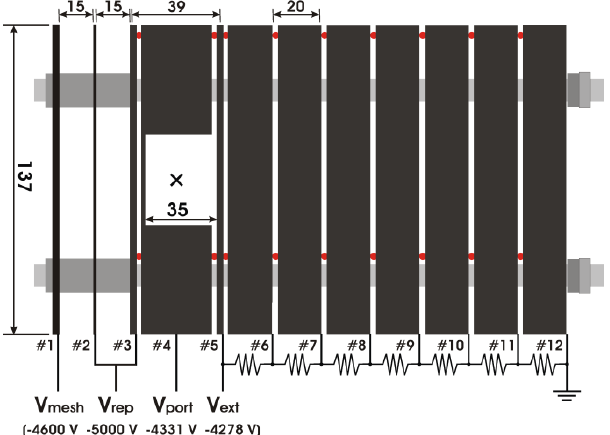
Figure 2. Electrostatic lens system of our imaging spectrometer (all dimensions in millimeters). A molecular beam is introduced from the left. The ionization point is indicated by the cross (×). Reproduced with permission from Ref. [23], copyright (2009) by American Chemical